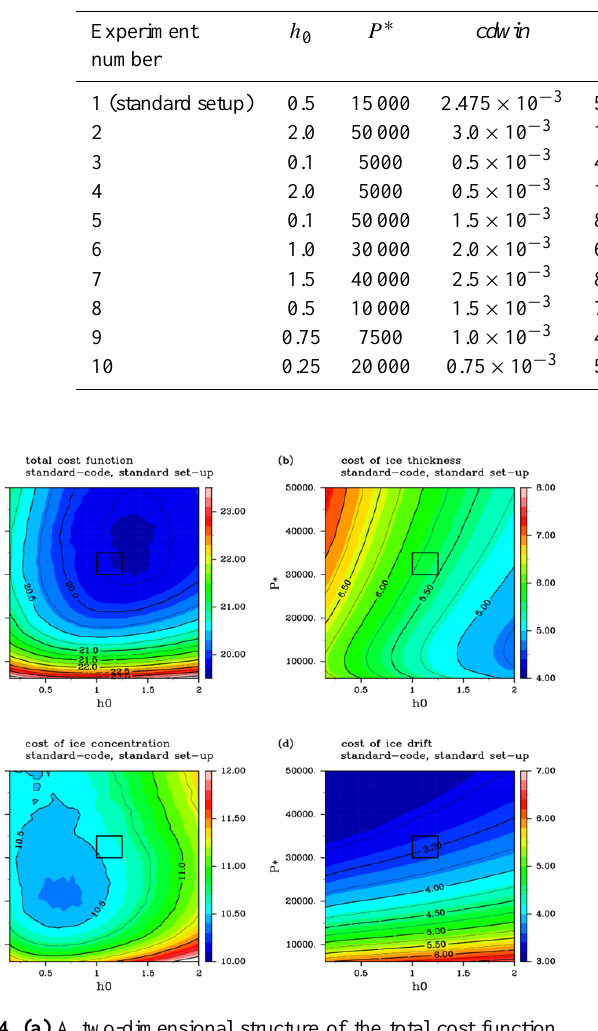
Table 4. Initial parameter sets for optimization experiments with the FD method.